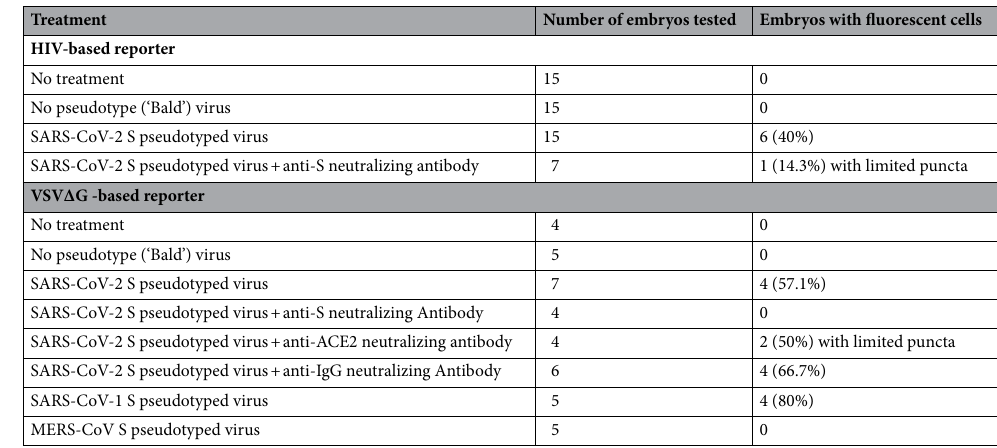
Table 1. Summary of experiments using pseudotyped reporter virions. For each reporter virion (HIV- or VSV∆G -based), the table indicates the experimental condition, the number of embryos used, and the number/ percent of infected embryos as evidenced by GFP signal.